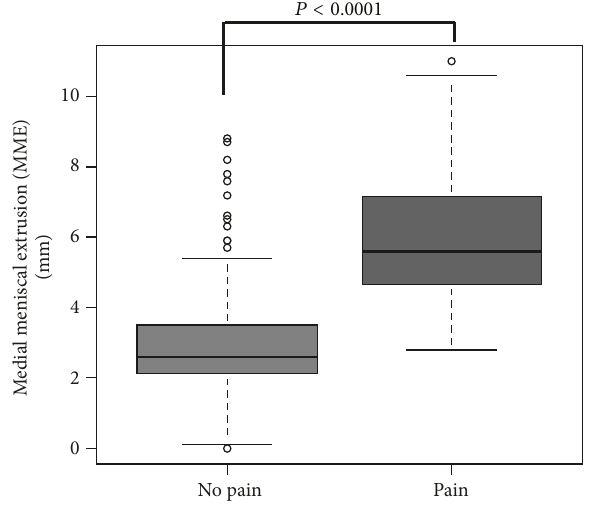
Figure 1: The relationship between medial meniscal extrusion (MME) and knee pain. MME is significantly greater in the P-group (5.9 ± 1.8mm) than in the N-group (2.9 ± 1.5 mm; Student’s t -test, 𝑃 < 0.0001 ).